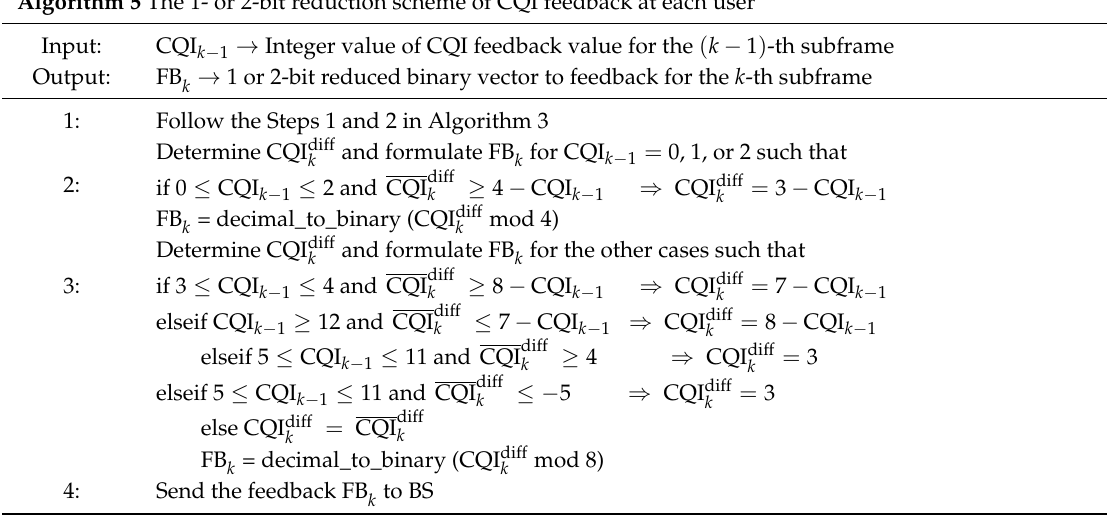
Algorithm 5 The 1- or 2-bit reduction scheme of CQI feedback at each